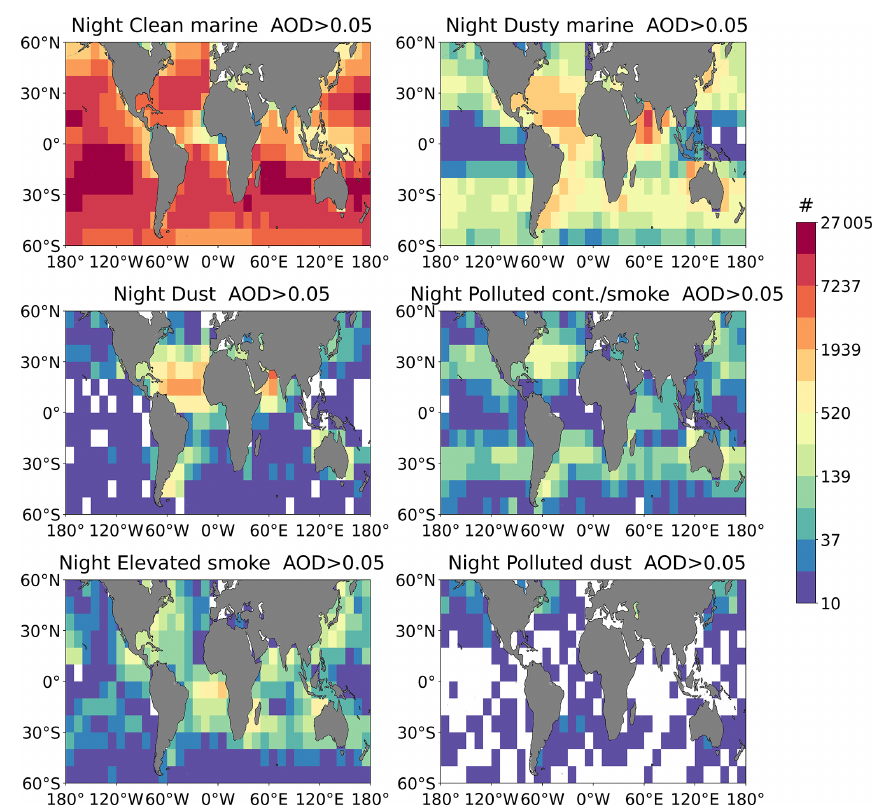
Figure A2. Geographical distribution of nighttime number of samples used in this study.